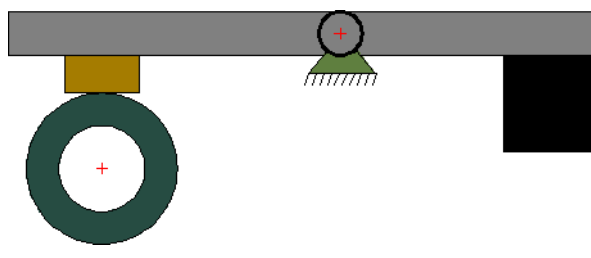
Figure 1: Block-on-ring wear